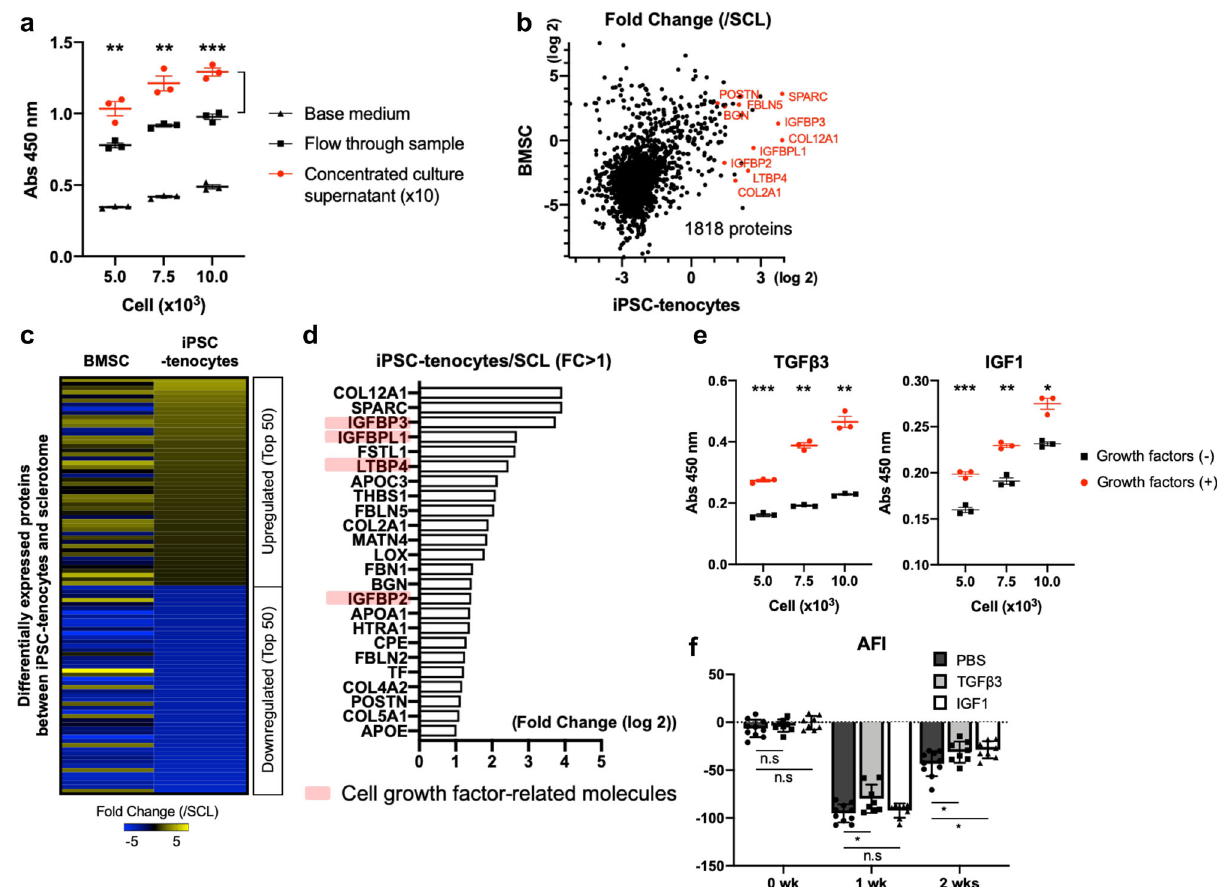
Fig. 6 iPSC-tenocytes secrete cytokines that promote tenocyte proliferation and motor function recovery. a Effect of concentrated culture supernatant of iPSC-tenocytes on primary tenocyte proliferation as assessed by cell proliferation assay. The statistical signi fi cance of the difference between the concentrated supernatant sample and the fl ow-through sample was assessed ( n = 3: biologically independent samples). b Scatterplot distribution of 1,818 proteins detected in the culture medium of both iPSC-tenocytes and BMSCs. Fold changes (log 2) compared to iPSC-derived sclerotome are shown. c Heatmap showing the top 100 differentially expressed proteins in iPSC-tenocytes vs. iPSC-derived sclerotome. Protein expression in BMSCs is also shown for comparison. d List of extracellularly secreted proteins highly (log2[fold change] > 1) expressed in iPSC-tenocytes compared to iPSC-derived sclerotome. e Effects of exogenous TGF β 3 and IGF1 administration on tenocyte proliferation in vitro as assessed by cell proliferation assay ( n = 3: biologically independent samples). f Kinematic analyses of rats treated with recombinant TGF β 3 or IGF1 proteins. AFI was measured at weeks 0 (before surgery), 1, 2 after transplantation (PBS: n = 10: biologically independent samples; TGF β 3 and IGF1: n = 8: biologically independent samples). * P < 0.05; ** P < 0.01; *** P < 0.001 by multiple-comparisons two-tailed t-test ( a ) or two-tailed Welch ’ s t-test ( e , f ). Data represent mean ± SE. n.s., not signi fi cant. Source data are provided as a Source Data fi